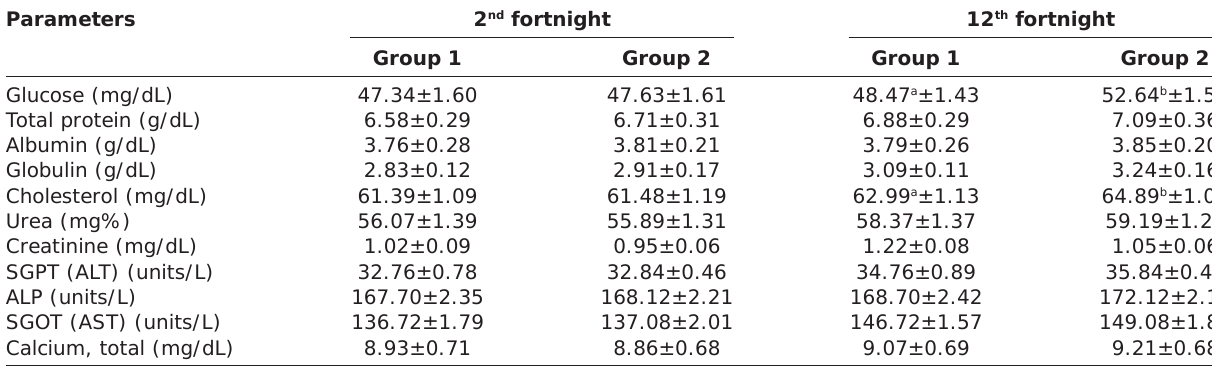
Table 5: Serum biochemical profiles in lamb Parameters 2 nd